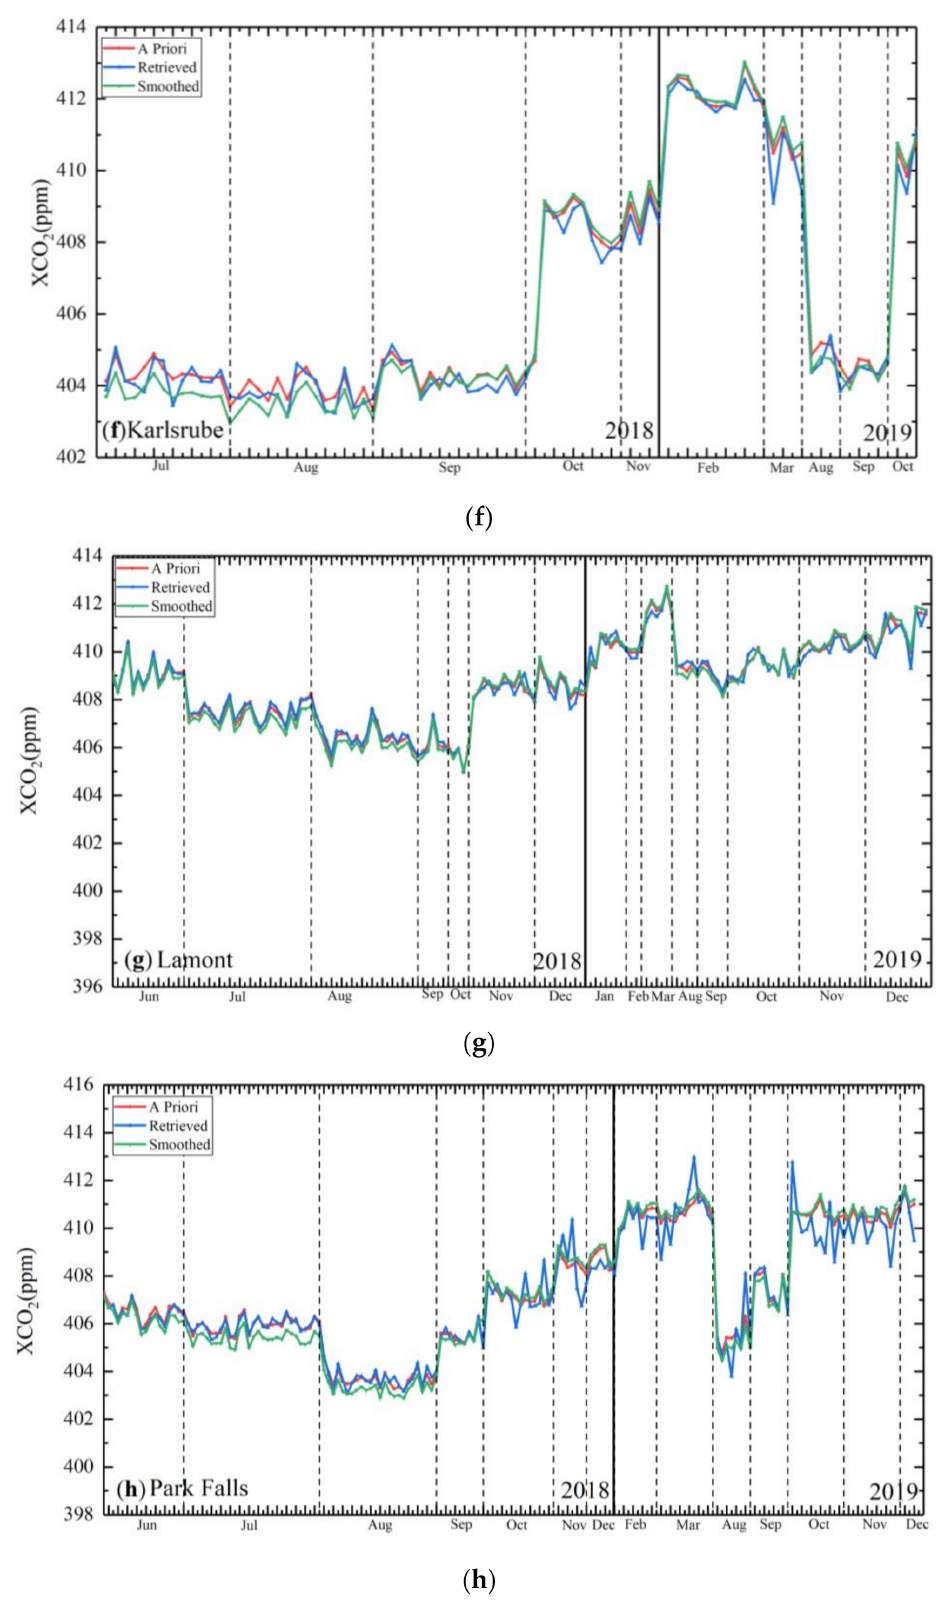
Figure 9. XCO 2 comparisons between a priori (red line), CrIS inversion (blue line), and smoothing Total Carbon Column Observing Network (TCCON) (green line) observation products. ( a ) Caltech, ( b ) East Trout Lake, ( c ) Edwards, ( d ) Garmisch, ( e ) Izana, ( f ) Karlsrube, ( g ) Lamont, and ( h ) Park